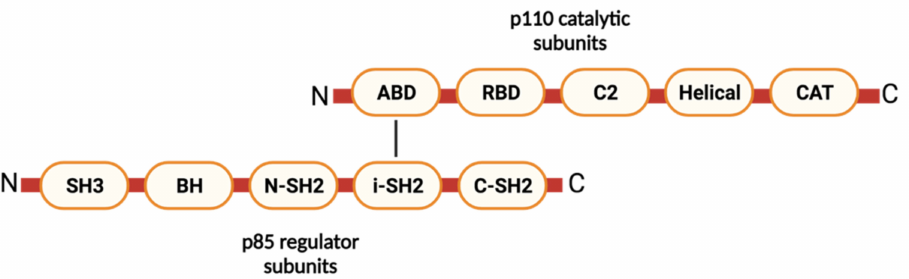
Figure 2. Structure of class IA PI3K (created with BioRender.com). Each class IA PI3K consists of p110 catalytic and p85 regulatory